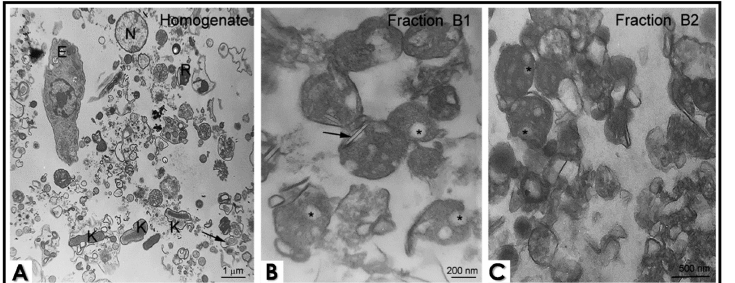
Figure 2. Ultrastructure of epimastigote cell fractionation by transmission electron microscopy. ( A ) Total homogenate shows cell debris, reservosomes (R), nuclei (N), whole epimastigote (E), membrane profiles, flagella ( black arrow ) and kinetoplast (K). Fractions B1 and B2 are enriched in reservosomes, although B1 presents more reservosomes containing lipid inclusions. ( B ) Cholesterol-rich inclusions are frequently observed in a flattened shape ( black arrows ) or as a rounded inclusion in the reservosome lumen ( asterisk ). ( C ) Reservosomes from Fraction B2 are more electron dense, and lipid inclusions are less abundant ( asterisk ), suggesting that there are subpopulations of these organelles. The images are a representative set of three independent experiments.